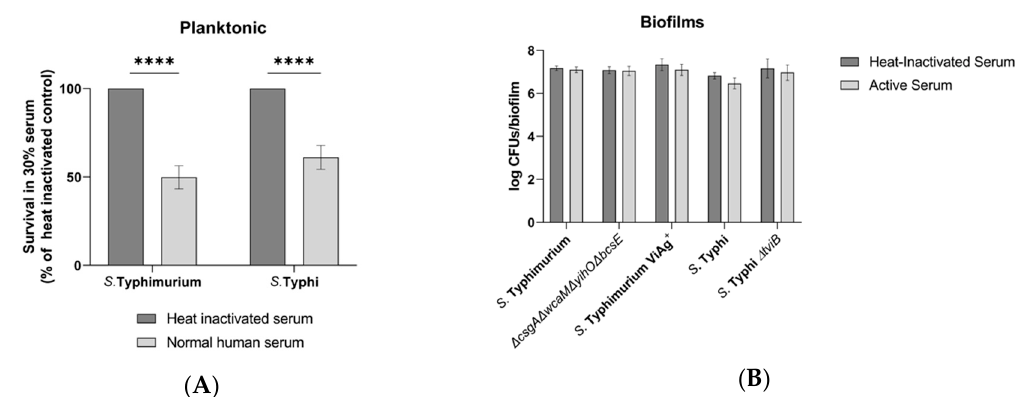
Figure 1. Sensitivity and tolerance to human serum. JSG698 was used for wild-type (WT) S. Typhi. ( A ) Growth from input of WT planktonic Salmonella following challenge with 30% normal human serum or heat-inactivated serum determined by colony forming unit (CFU) enumeration (data are normalized to heat-inactivated control) ( n = 5). Significance between conditions was identified by multiple t tests using the Holm–Sidak method ( α = 0.05) to correct for multiple comparisons (****, P < 0.000001). ( B ) CFU enumeration of biofilms following the same conditions as planktonic bacteria. Significance difference were tested for using two-way analysis of variance (ANOVA) and the Sidak method to correct for multiple comparisons ( n = 4, daily experiments conducted in quintuplicate). Error bars indicate standard deviation (SD).